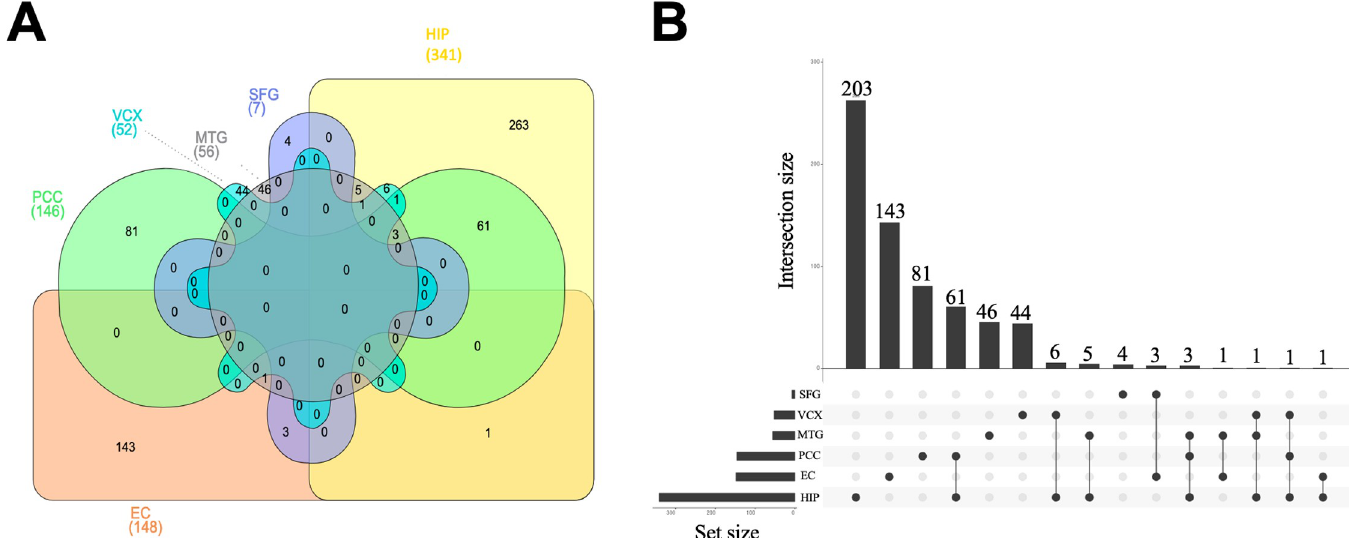
Fig 9. Venn diagram and UpsetR plot of switch genes from different brain regions. A. The Venn diagram was created using http://www.interactivenn.net/. The genes symbols were imported for the different brain areas. EC: Entorhino cortex, HIP: Hippocampus, MTG: Mid Temporal Gyrus, SFG: Superior Frontal Gyrus, PCC Posterior Cingulate, VCX: Primary Visual Cortex. B. The UpSetR plot was created as described [37]. The horizontal bars with labels at the lower left of the panel represent the six data sets that were included in the Venn diagram, with the length of each bar displaying the total set size. The dot pattern to the right shows the intersections between the sets. The vertical bars at the top show the size of the corresponding intersection, ranked by decreasing set size, where a gray dot indicates an empty set and a single black dot indicates no intersection with another set.